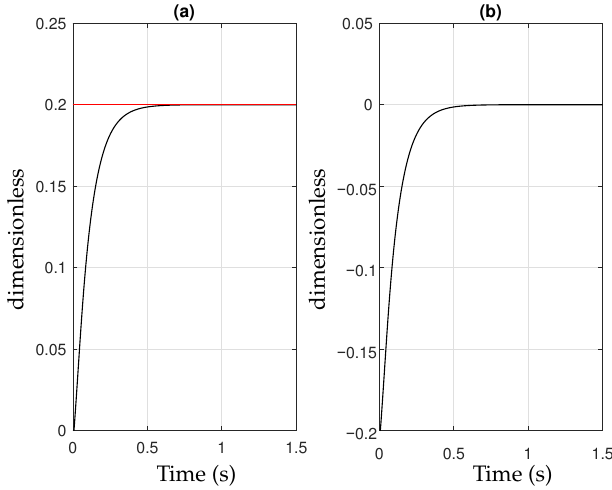
Figure 4. ( a ) Wheel slip λ (black) and reference λ ref (red); ( b ) tracking error λ − λ ref .